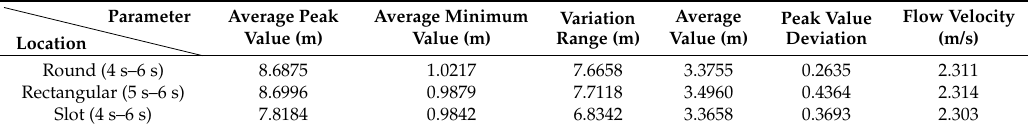
Table 14. Flushing results when different shape nozzles are set on top of the pipe.